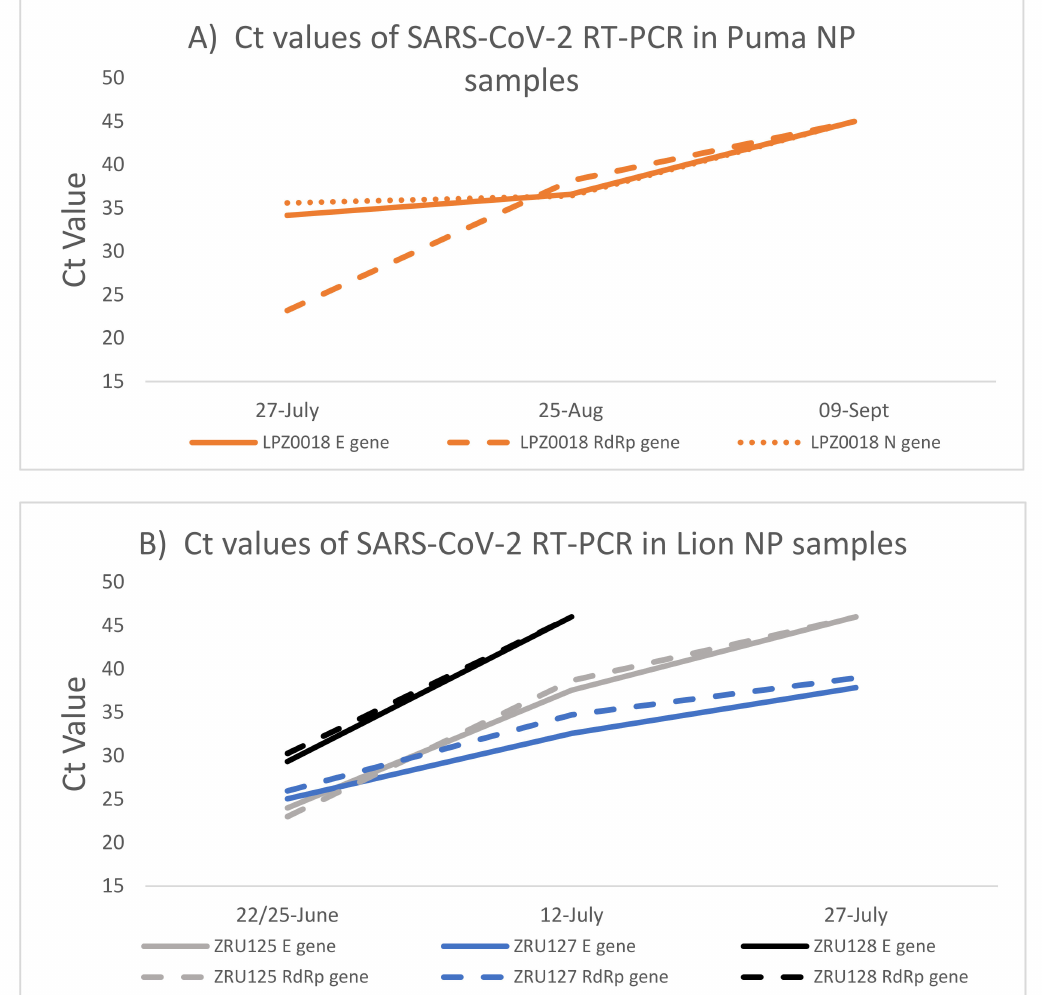
Figure 2. SARS-CoV-2 RNA load in puma and lions measured by RT-PCR over time. ( A ): Ct values detected in NP samples of the puma (LPZ0018). ( B ): Ct values detected in NP samples of the three lions. NP—Nasopharyngeal swab; E—SARS-CoV-2 envelope gene (solid lines); RdRp -SARS- CoV-2 RNA dependent RNA polymerase gene (dashed lines); N—SARS-CoV-2 nucleocapsid gene (dotted